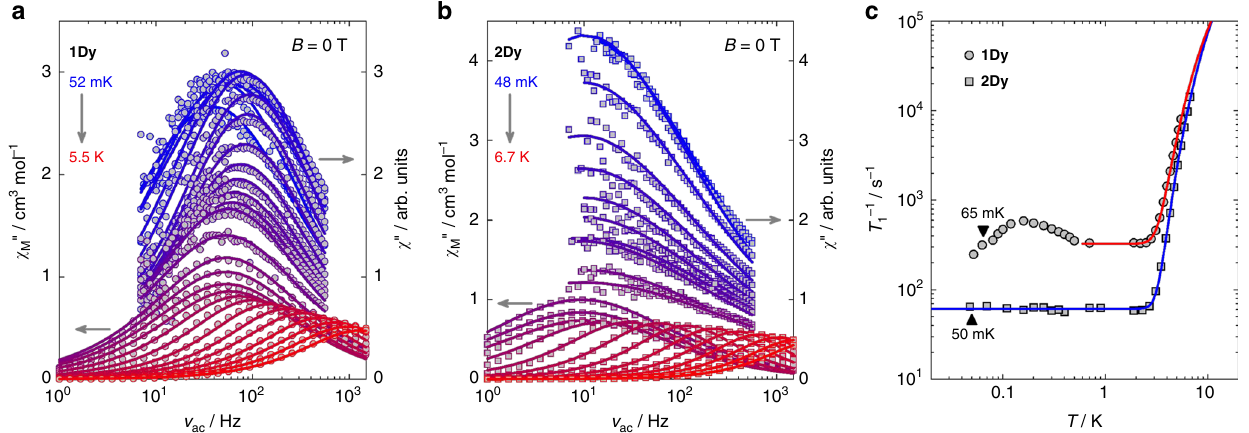
Fig. 4 Electronic spin relaxation. Frequency dependence of the out-of-phase component of the ac magnetic susceptibility at zero applied dc fi eld for 1Dy ( a ), and 2Dy ( b ) in the mK temperature range (right-hand ordinate) and at standard liquid helium temperatures (left-hand ordinate). The solid lines are best fi ts to Cole – Cole functions. The electronic spin-lattice relaxation (SLR) rates T 1 − 1 for 1Dy and 2Dy ( c ) extracted from Cole – Cole fi tting of the data in a and b . The solid lines are best fi ts to Eq. (2), and the denoted temperatures correspond to the estimated Néel